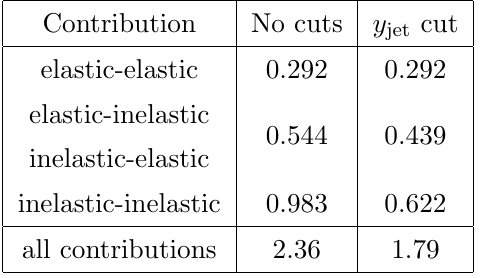
p Table 1 . Cross section in fb at s = 13 TeV for di(cid:11)erent components (left column) and the same when the extra condition on the outgoing jet j y jet j > 2 : 5 is